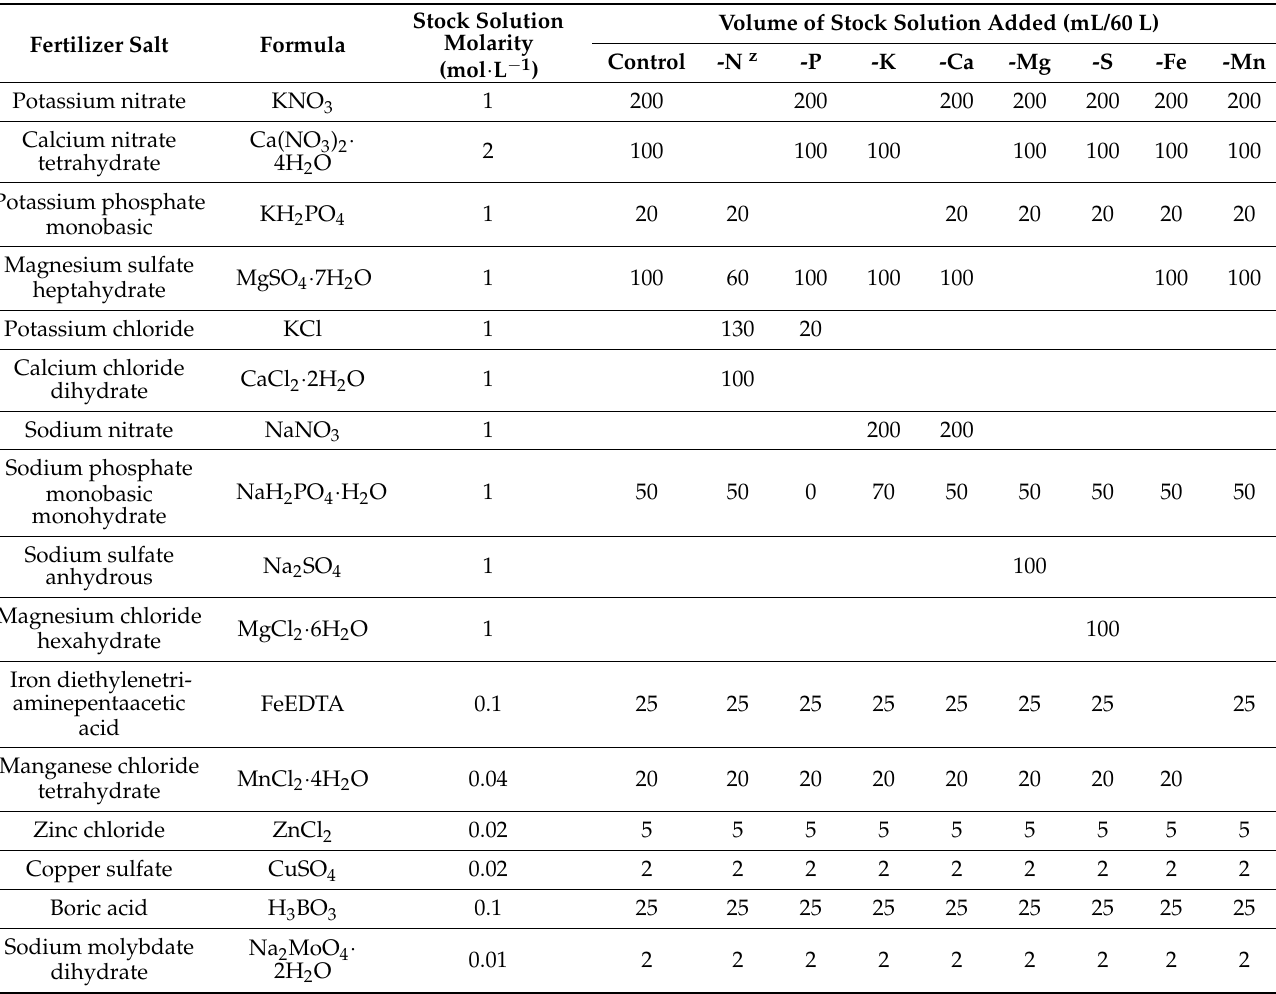
Table 2. Concentrations of single salt stock solutions and the composition of each of the treatment